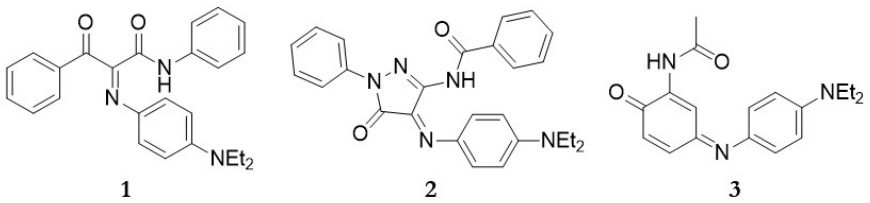
Figure 1. Structure of the dyes used as reference for yellow ( 1 ), magenta ( 2 ) and cyan ( 3 ) colour.